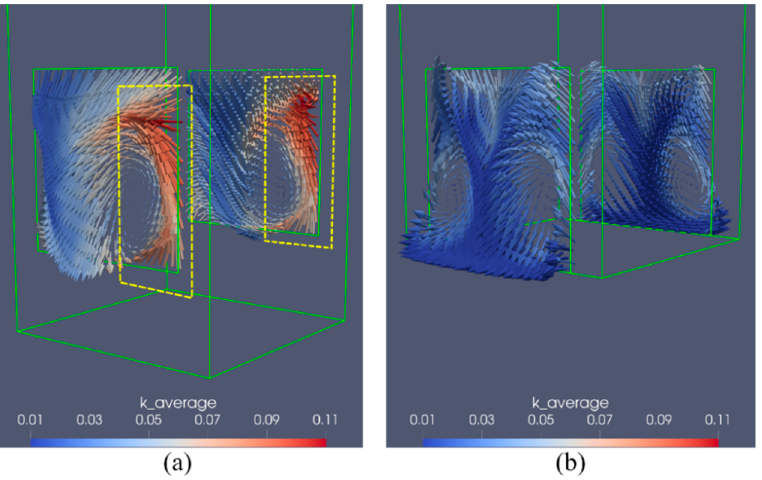
Figure 5. Hydrodynamic behavior at the exit ports. ( a ) Type A NIP and ( b ) Type A NIP. The length of the vectors is proportional to the velocity magnitude and their color is given by value of average κ . Yellow dashed boxes outline highly turbulent regions of the flow directed upwards.